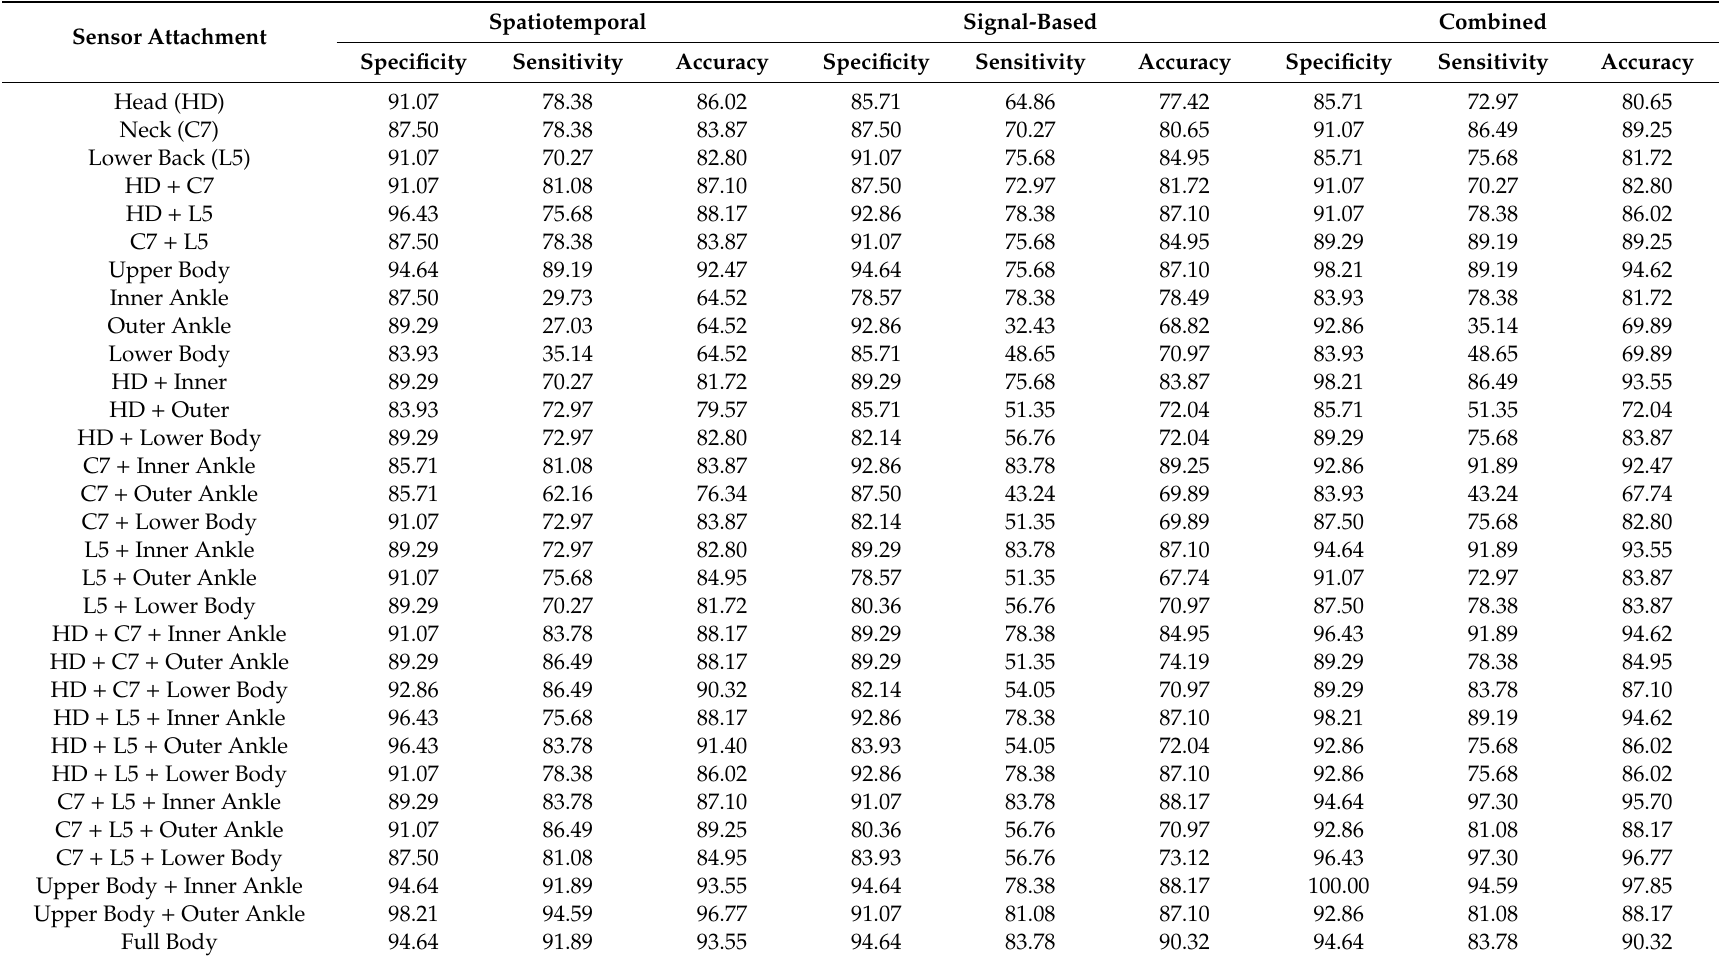
Table A1. Classification accuracy (%) based on PLS-DA trained on a combination of